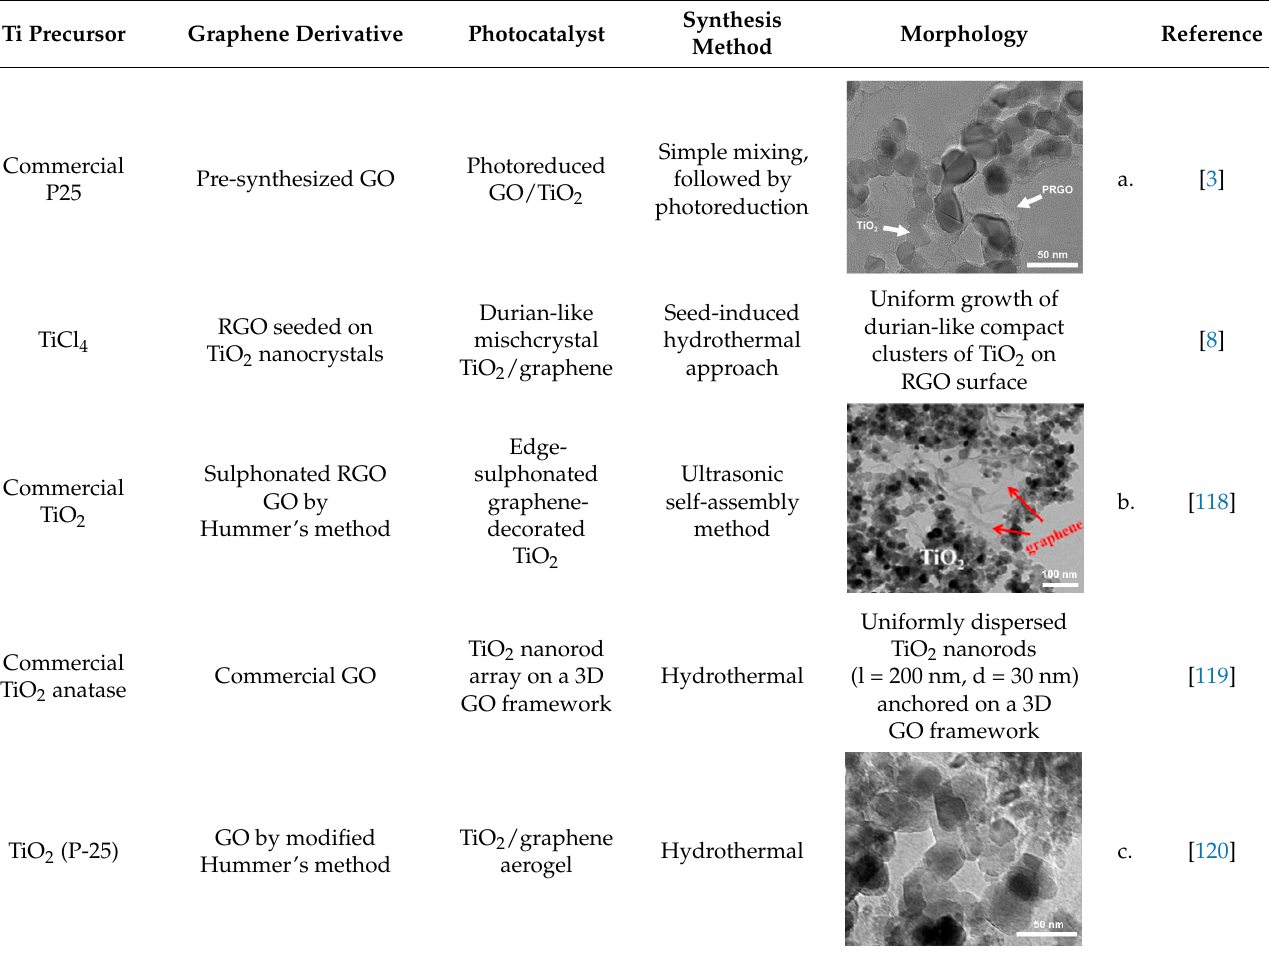
Table 2. An overview of the recent methods for the design of graphene-based/TiO 2 composites.